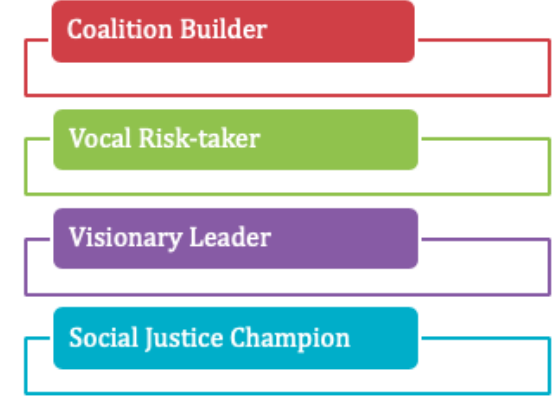
Figure 2. The Multi-Profile